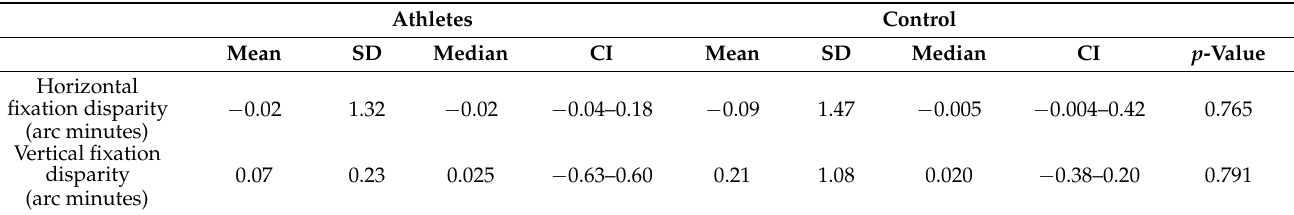
Table 3. Fixation disparity